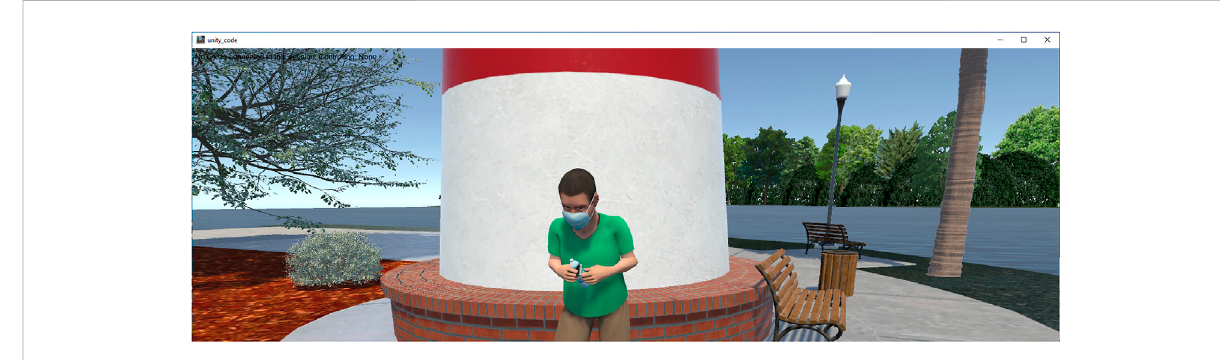
FIGURE 2 Martin in the training scenario at level 4, calm and holding a water bottle.